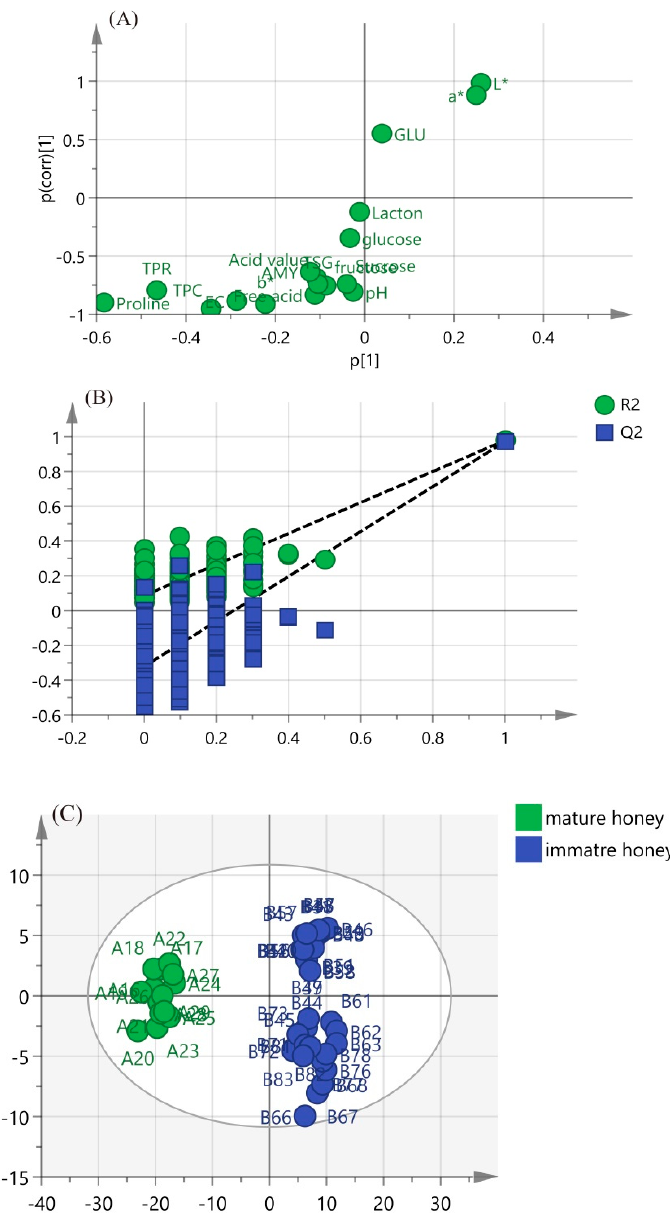
Figure 5. The orthogonal partial least squares-discriminant analysis (OPLS-DA) S-plots ( A